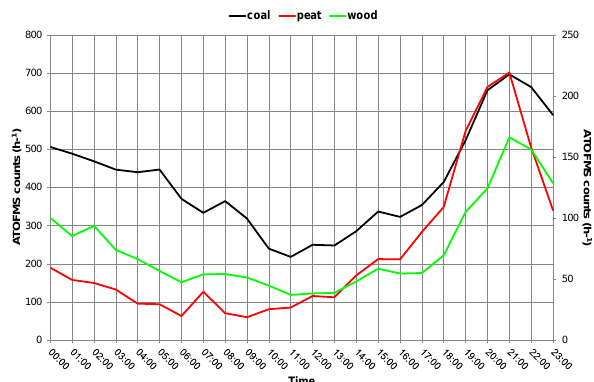
Fig. 6. Average diurnal trend for Coal, Peat and Wood ATOFMS particle counts for 7–28 August